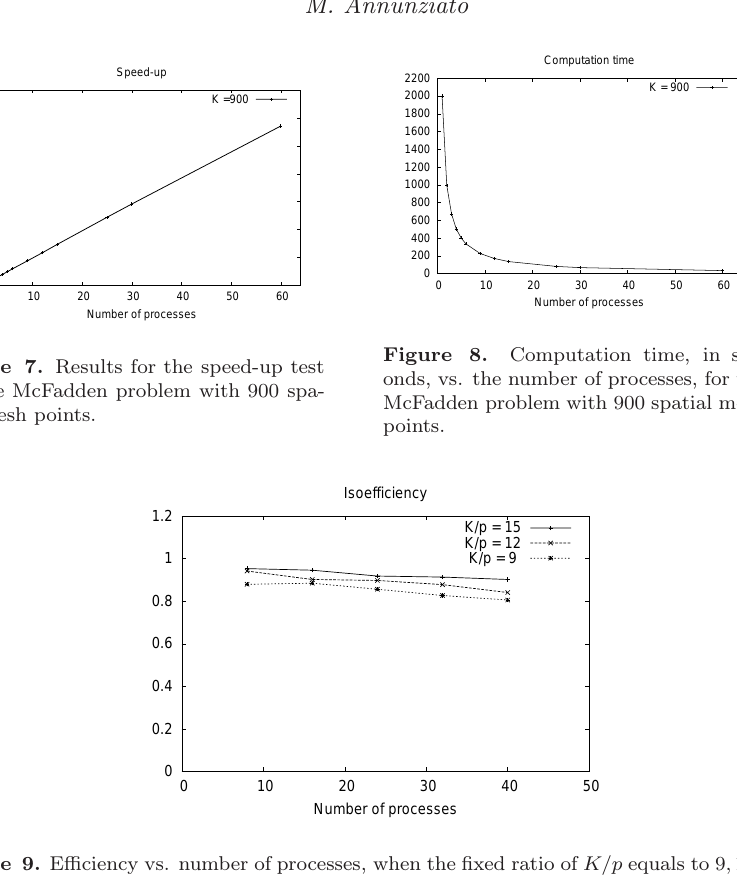
Figure 9. Efficiency vs. number of processes, when the fixed ratio of K/p equals to 9 , 12 , 15